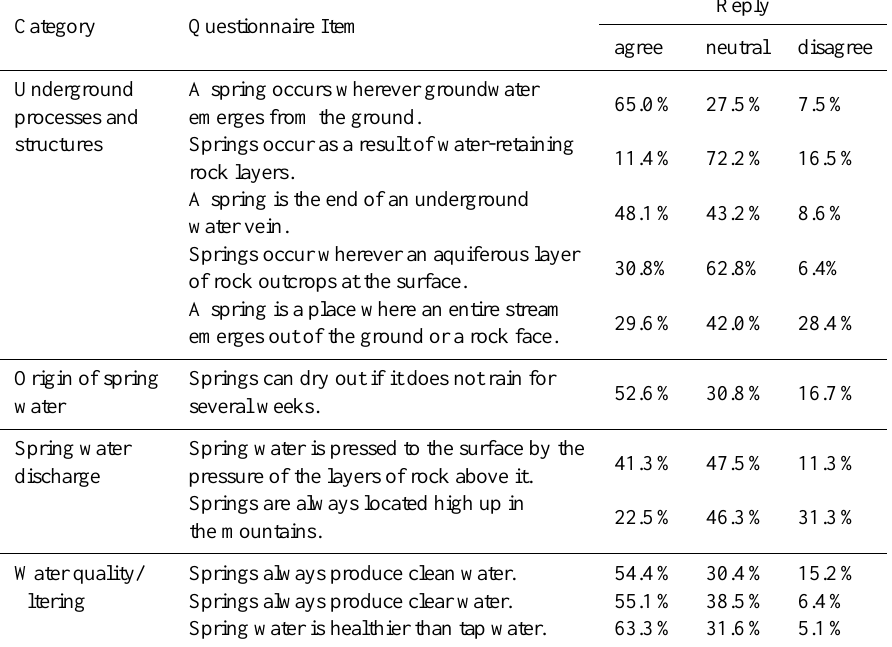
Table 1. Students’ replies to selected questionnaire